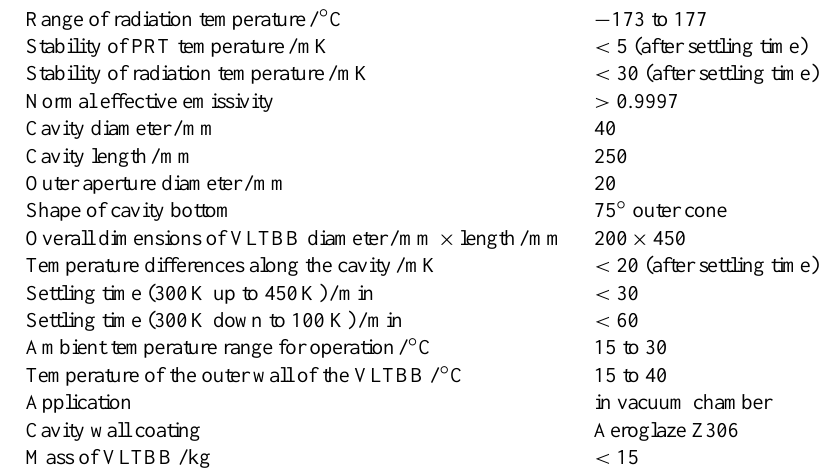
Table 1. Basic parameters and performance of the VLTBB.